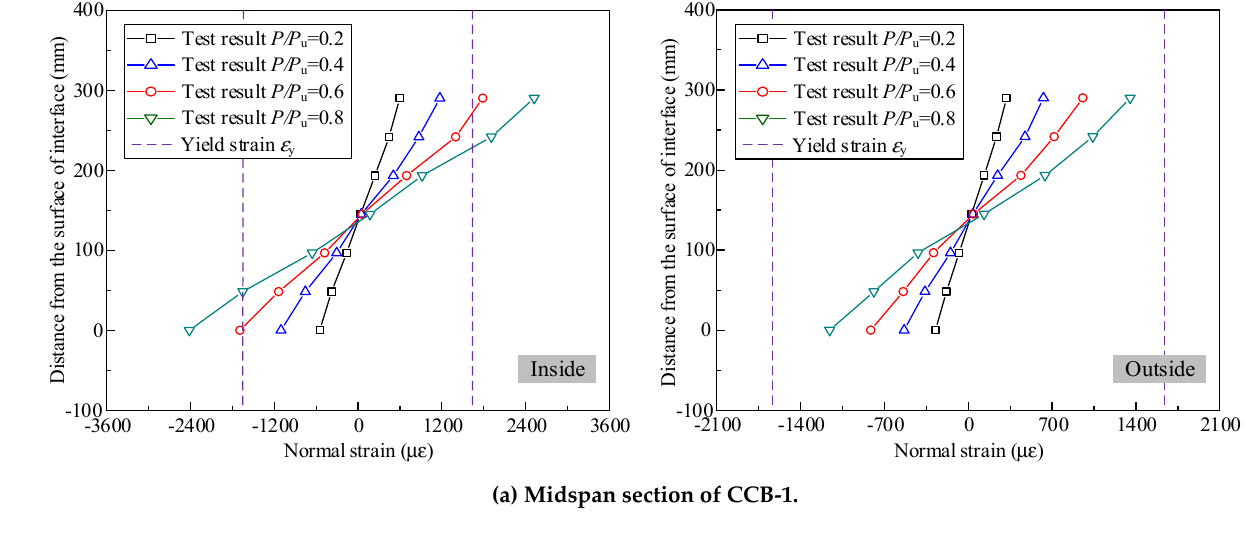
(a) Midspan section of CCB-1.